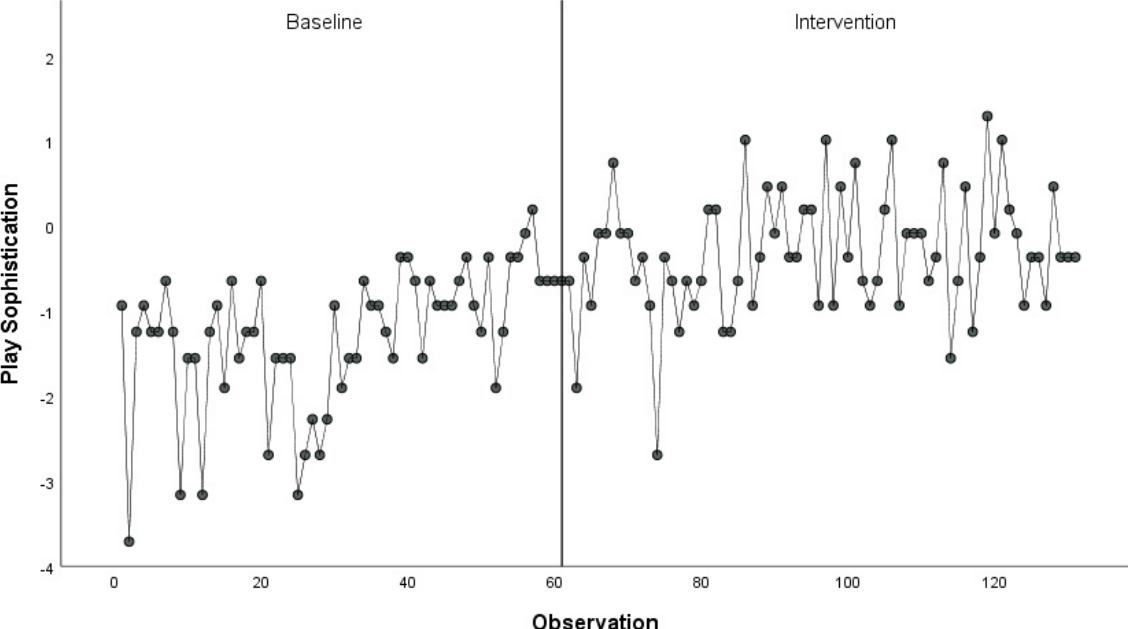
Figure 2. Playground observation scores during baseline and intervention at School